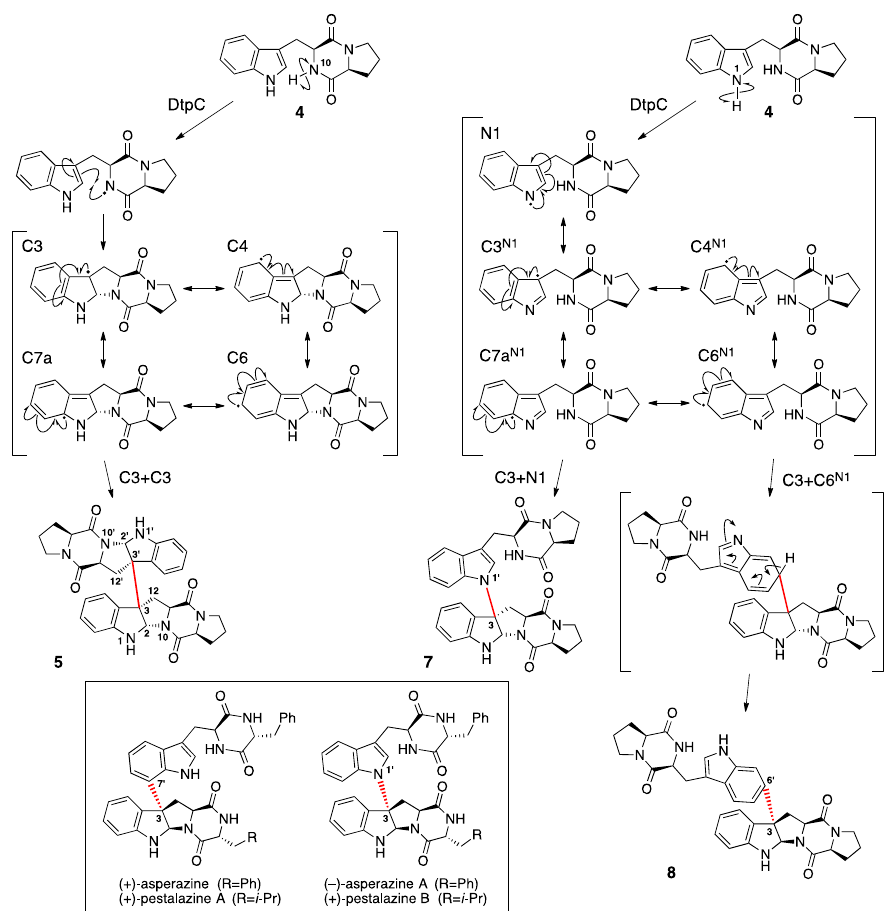
Figure 6. Proposed mechanism of DtpC-catalyzed formation of dimerization products ( − )-dibrevianamide F 5 [9], a new compound 7 [14] and naseseazine B 8 [15]. Radical-mediated formation of 7 and 8 is thought to be initiated by DtpC forming a radical at N1 instead of N10 as proposed for the formation of 5 . The radical species are labeled by the position of the radical. To differentiate between radical species derived from hydrogen extraction at N10 ( left column ) vs. N1 ( right column ), those formed via the N1 hydrogen extraction are given a label with a superscript N1. Chemical structures of related known natural products are shown in the box. The monomer-bridging bonds are shown in red.